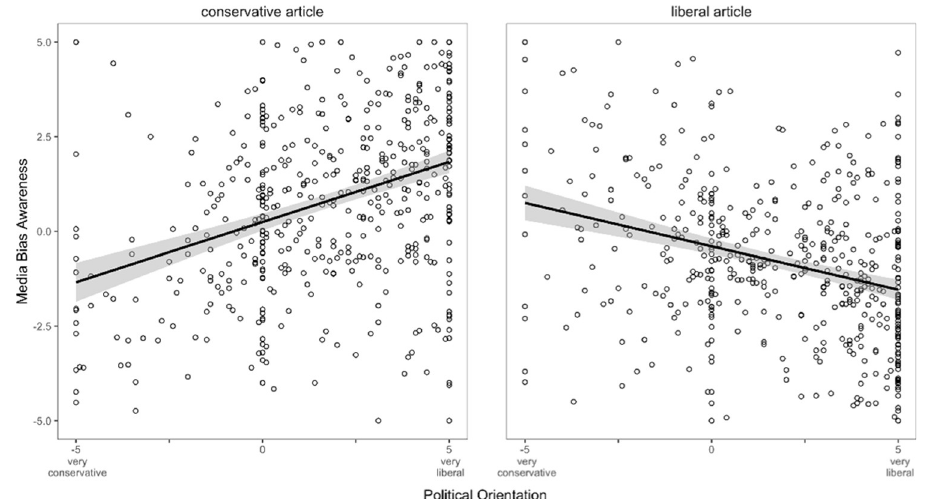
Fig 5. Partisan effects on media bias awareness ratings of conservative and liberal articles. Bias awareness increases when the article is not aligned with the persons’ political position. Shades show 95% confidence intervals of the regression